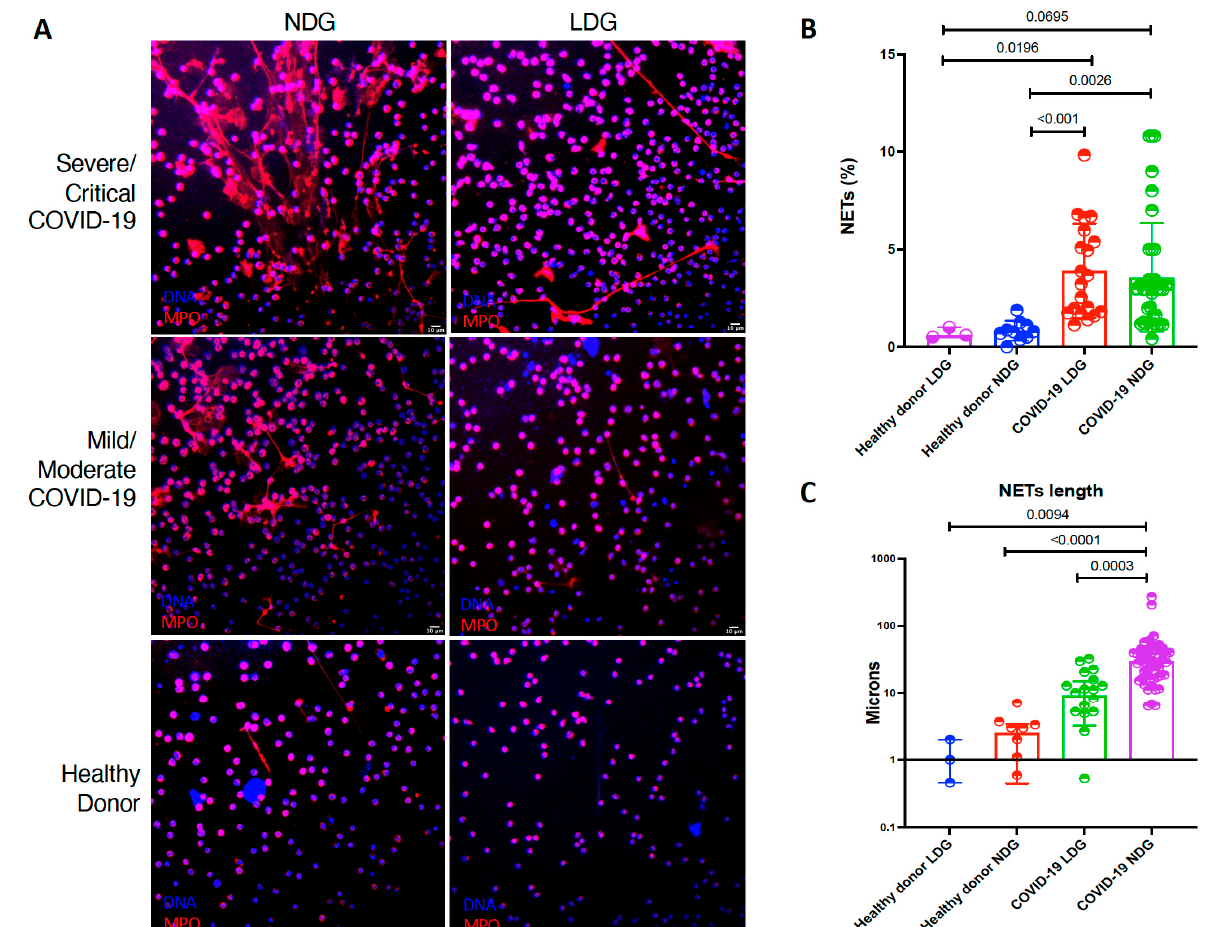
Figure 2. LDG and NDG from COVID-19 patients are prone to spontaneous NET release. ( A ). Representative confocal microscopy image of the spontaneous NETs from COVID-19 neutrophil subsets according to disease severity. ( B ). LDG ( n = 20) and NDG ( n = 18) from COVID-19 patients have a higher percentage of NETs in comparison to healthy donor LDG ( n = 3) and NDG ( n = 10). ( C ). NETs secreted by NDG from COVID-19 patients have a higher length in comparison to COVID-19 LDG and healthy donor both NDG and LDG. Medians were compared using the Kruskal–Wallis test with Dunn’s multiple comparison test. The length of NETs is expressed in a logarithmic scale.